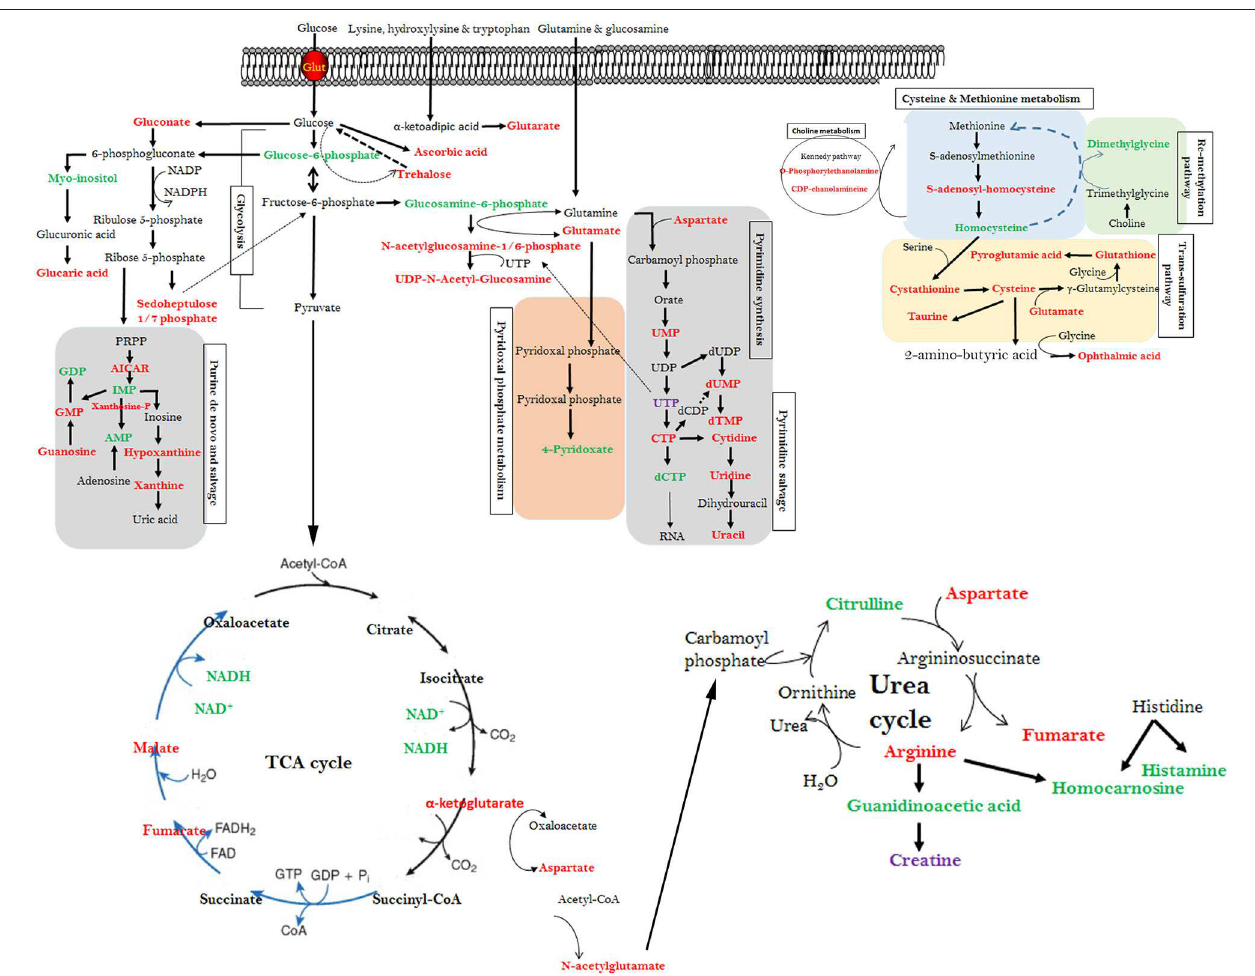
FIGURE 5 | Interconnected altered metabolic pathways in WB-affected muscles. Altered metabolites from the top canonical pathway analysis along with their cross-independence in KEGG pathways. Red text metabolites represent elevated mean intensity in WB-affected, whereas green text represent reduced intensity. The figure is representative and not for